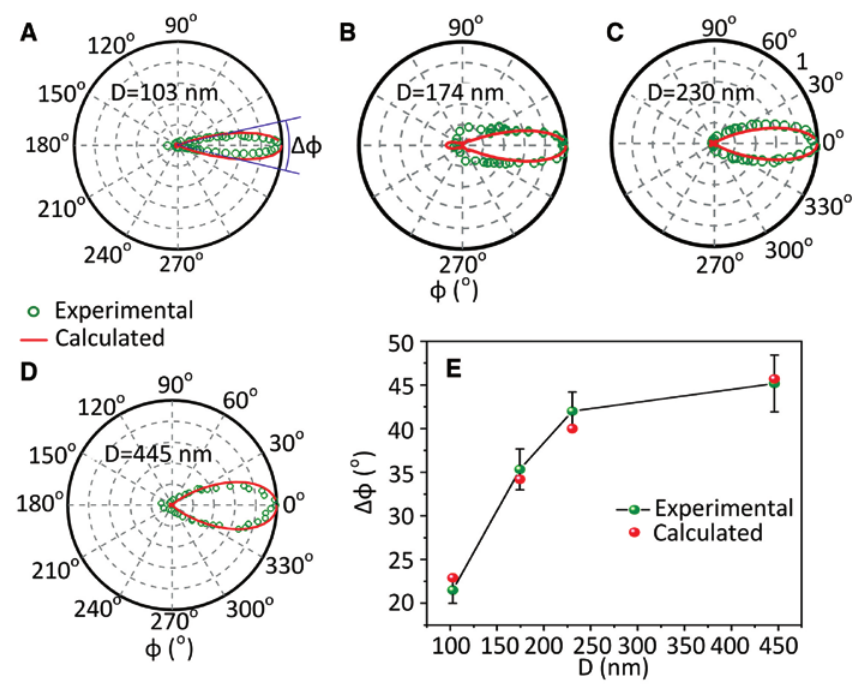
Figure 3: The radiation properties for unidirectional emission. (A–D) Normalized intensity distributions versus φ at θ extracted from the Fourier images. Hybrid nanowires (HNWs) with four different m = 1.33). The green circles and red solid lines represent the experimental and calculated dates, diameters were measured and calculated (n 1 respectively. (E) Experimental and calculated results with respect to half-power bandwidth (HPBW, Δ φ ) for diameter